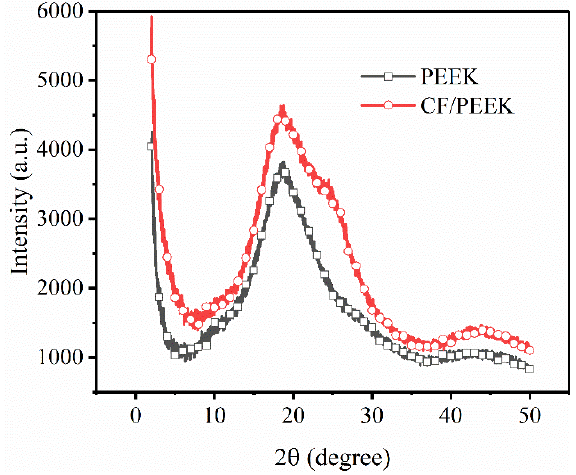
Figure 4. XRD pattern of the PEEK and CF/PEEK samples.